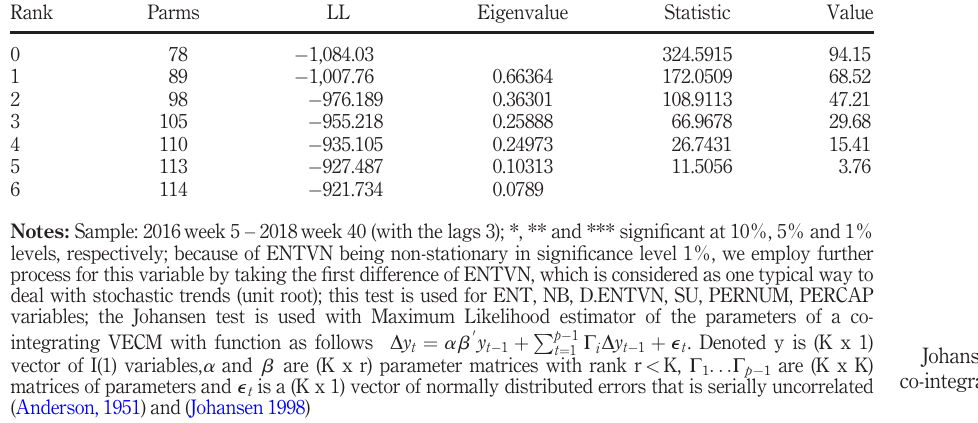
Table V. Johansen tests for co-integration for